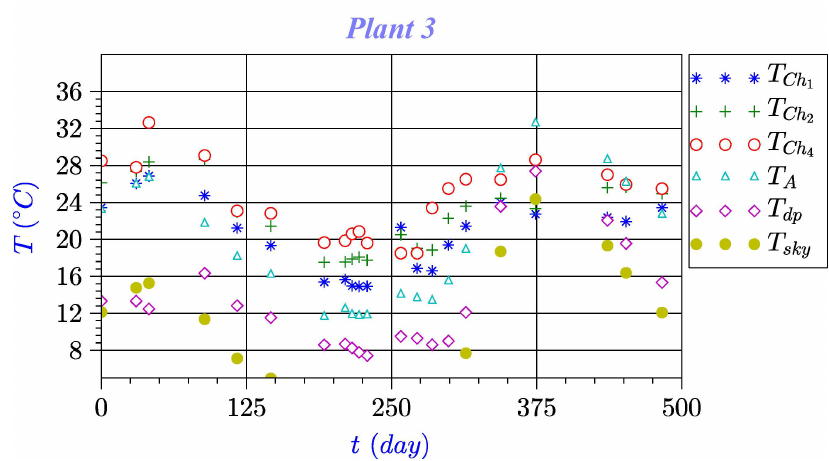
Figure 10. Temperature results for plant 1, 2, and